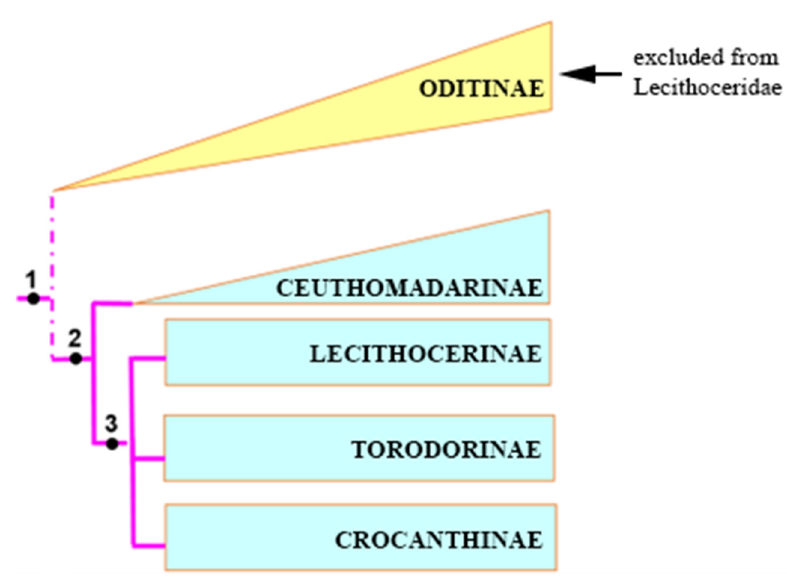
Figure 2. Diagram of the divisions of the subfamilies of Lecithoceridae (Park et al., 2022